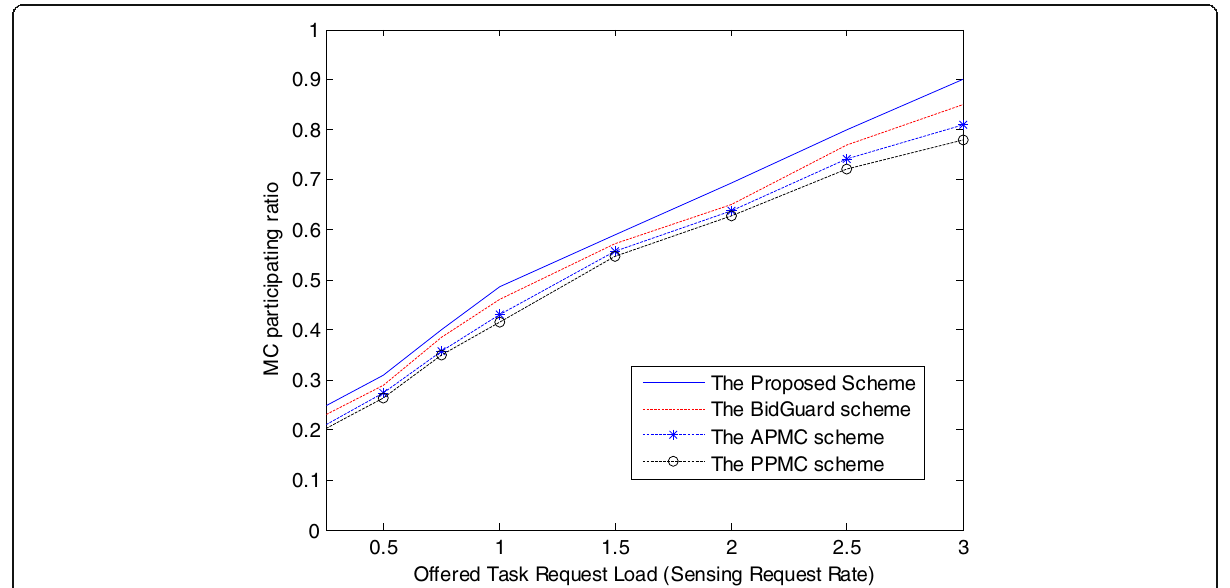
Fig. 2 MC participating ratio. For each scheme, the MC participating ratio is estimated from low to high task request